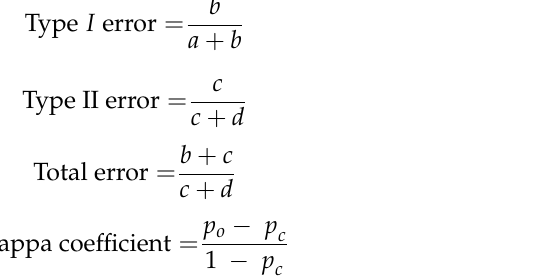
Table 3. Cross-matrix of filtering results.